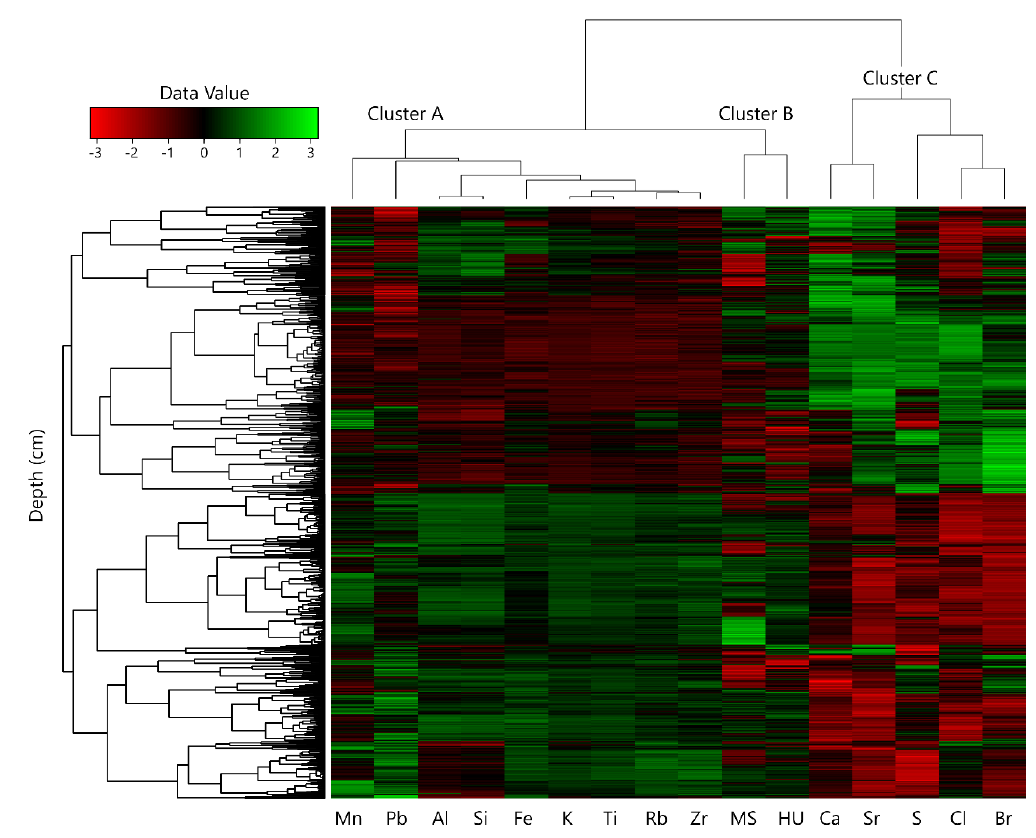
Figure 6. Hierarchical clustering heatmap of Pearson correlation coe ffi cients between non-destructive techniques results for each depth (cm) measured. The 3 main clusters that were exported are presented at the top of the